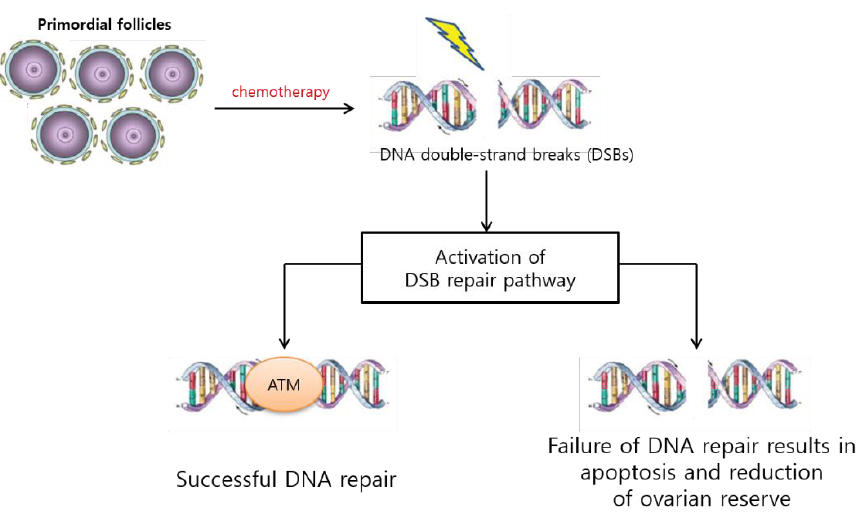
Figure 1. Chemotherapy-induced DNA double-stranded breaks (DSBs). If the DSB is repaired successfully, the cell survives via ataxia–telangiectasia mutated (ATM)-mediated DNA damage repair pathways. However, DNA damage can result in cellular apoptosis and a reduction in the ovarian reserve if the repair pathway fails.